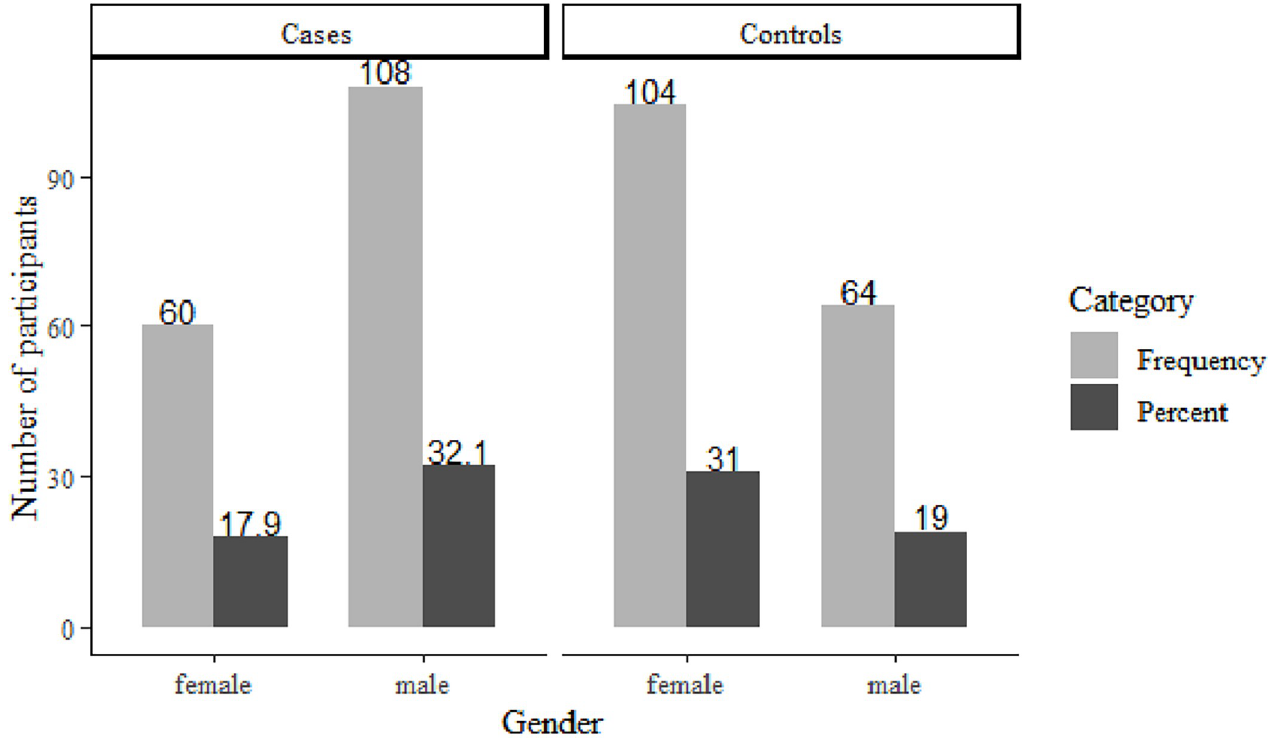
Fig 3. Demographic picture of gender distribution of participants. A higher proportion of childhood brain atrophy is shown in male children of the sampled population than in female children.